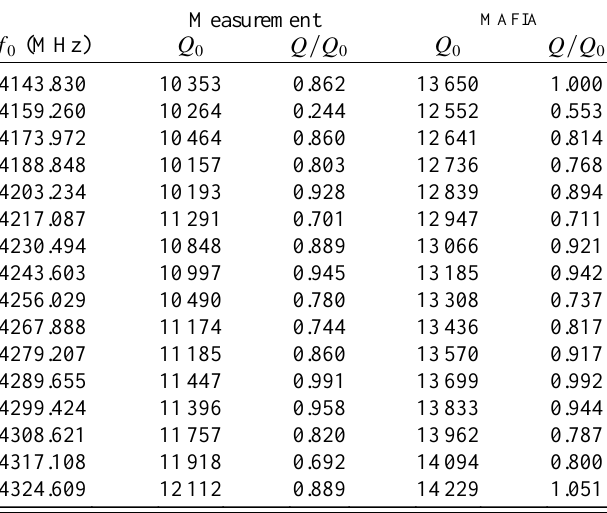
TABLE III. Measurement and MAFIA results. Measurement